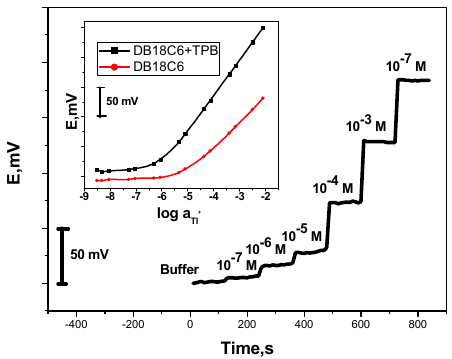
Figure 2. Time trace of the proposed sensors. Insert: Calibration curves of these ion sensors.